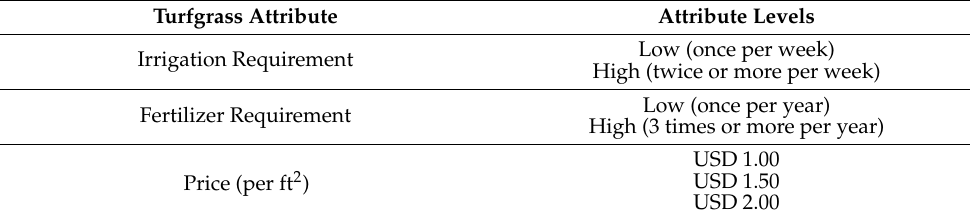
Table 1. Attributes and Attribute Levels for the Choice